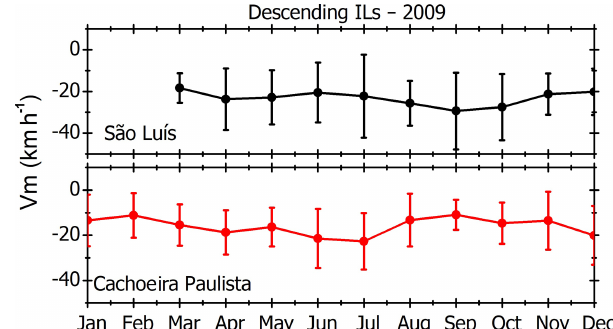
Figure 15. The monthly average descending velocity of intermedi- ate layers for São Luís and Cachoeira Paulista (black and red pro- files, respectively). The vertical bars represent the standard devia-